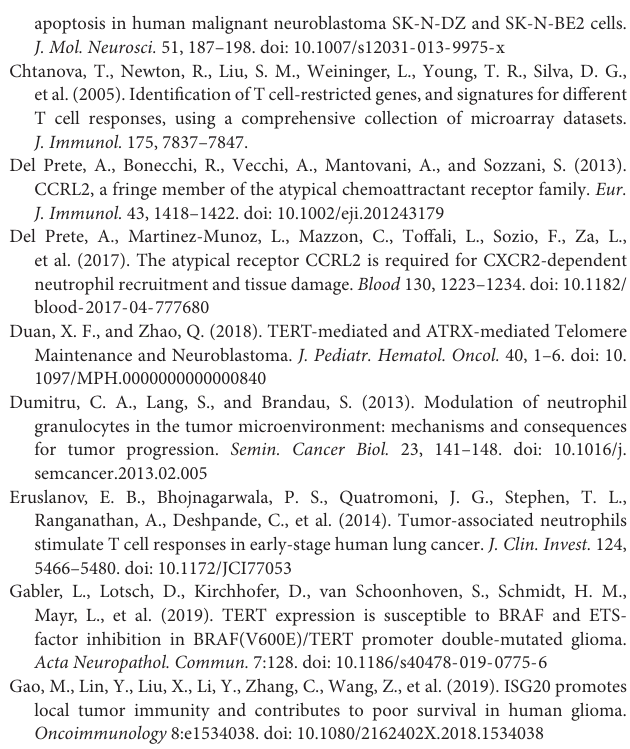
Supplementary Figure 1 | GSEA analyses of upregulated gene set enrichment in IDHwt glioma according to TERT mutation. (A) GO gene set enrichment in TERT mut glioma. (B) GO gene set enrichment in TERT wt glioma. (C) Immunologic gene set enrichment in TERT mut glioma. (D) Immunologic gene set enrichment in TERT wt glioma. Blue column with upper scale, NES; gray plot with lower scale, − log10 p -value; p <